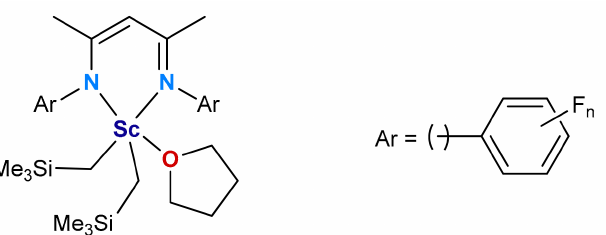
Figure 7. Fluorine substituted β -diketiminate Sc catalysts reported by Cui and coworkers (1 ≤ n ≤ 5)